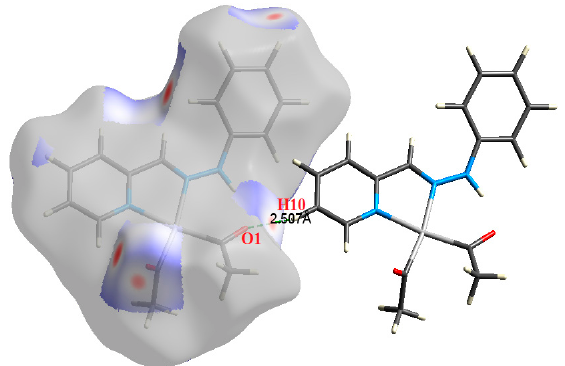
Figure 6. The most important intermolecular contacts in complex 4 .